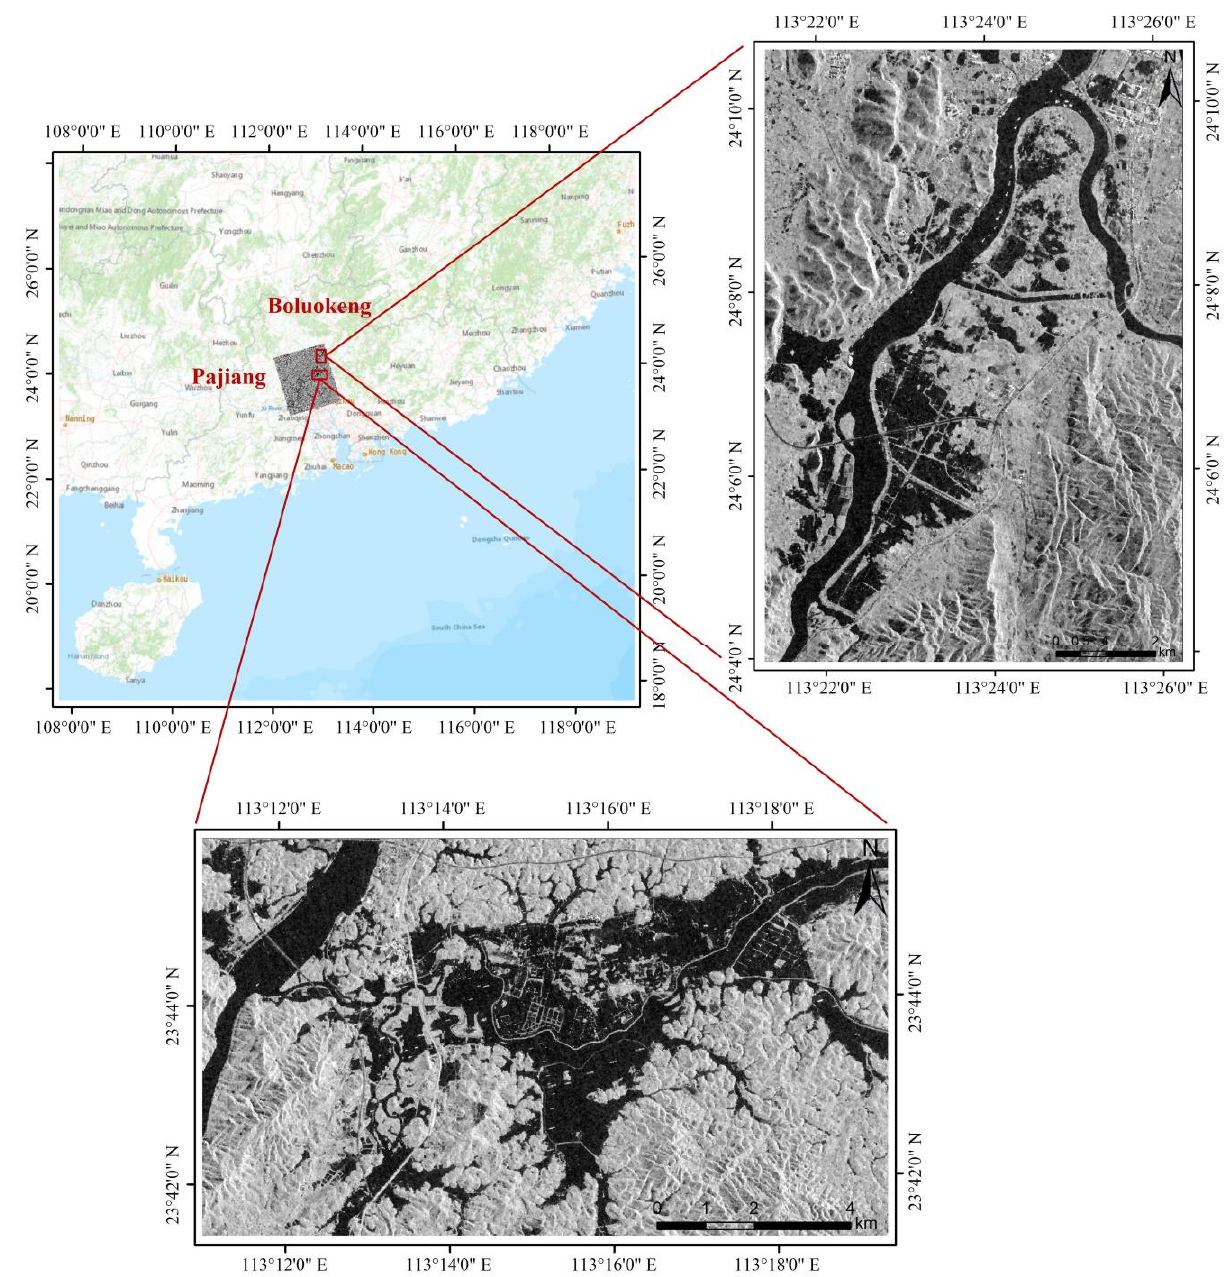
Figure 1. GF-3 images of Boluokeng and Pajiang.